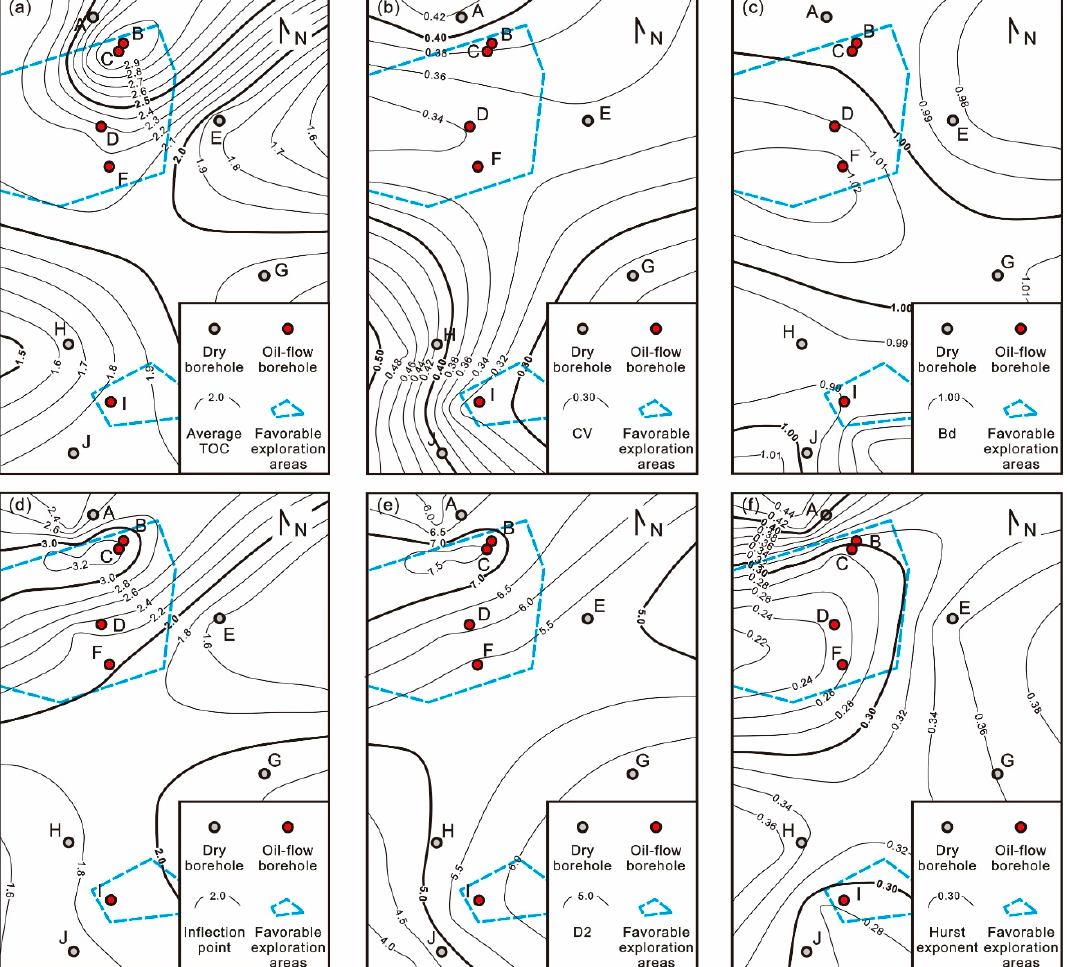
Figure 7. Predictive map of total organic carbon (TOC) exploration targets created based on statistical analysis and fractal modeling: ( a ) average TOC grades; ( b ) coefficients of variance (CV); ( c ) box dimensions (Bd); ( d ) inflection point of the bi-fractal; ( e ) fractal dimension 2 of the bi-fractal; and ( f ) Hurst exponents. Favorable areas marked in blue fit the threshold of fractal parameters.